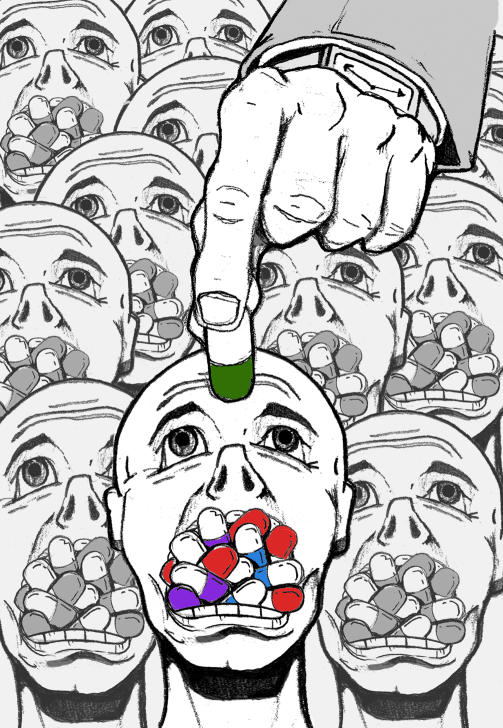
Most people in Western countries take medication to treat or prevent illness or enhance well-being(Illustration: Anthony Flores)